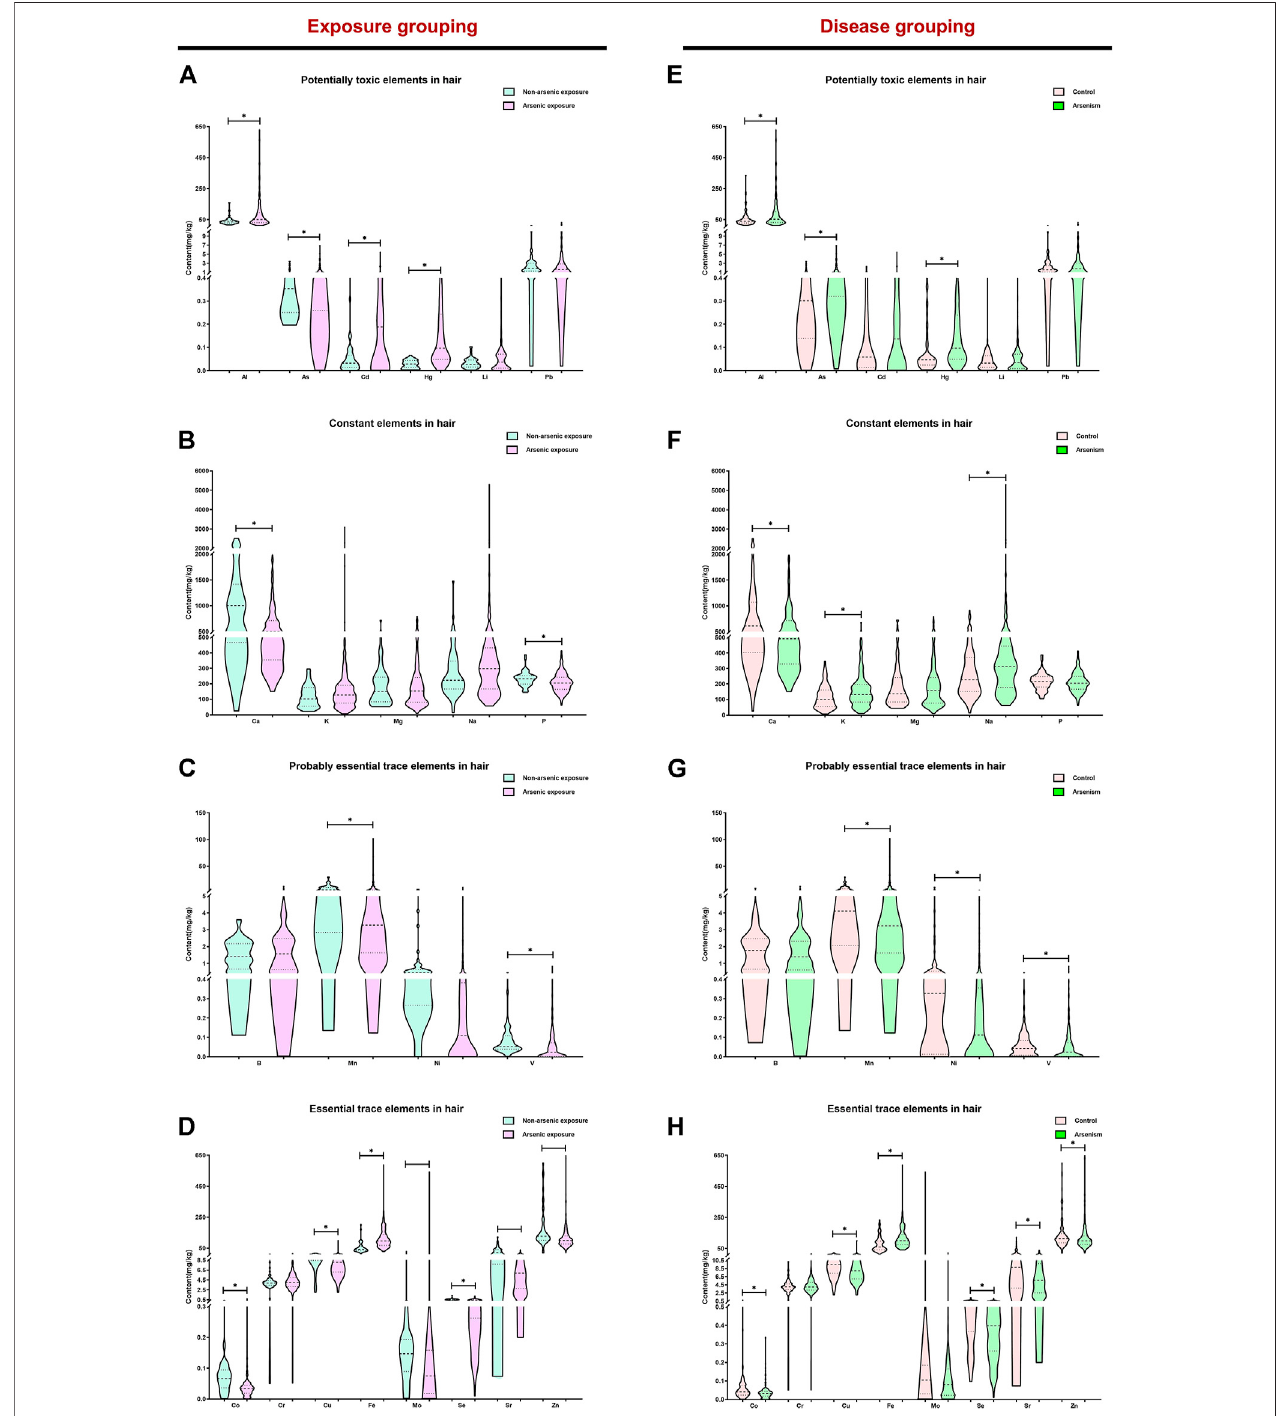
FIGURE 1 | The content of 23 elements in the hair of different groups. In this study, the median and interquartile range were expressed in the results, * p < 0.05. Based on exposure grouping, (A – D) the content of potentially toxic elements, constant elements, probably essential trace elements, and essential trace elements in different groups, respectively, is shown. Subsequently, based on disease grouping, the differences of potentially toxic elements, constant elements, probably essential trace elements, and essential trace elements in the two groups are clearly shown (E – H) .